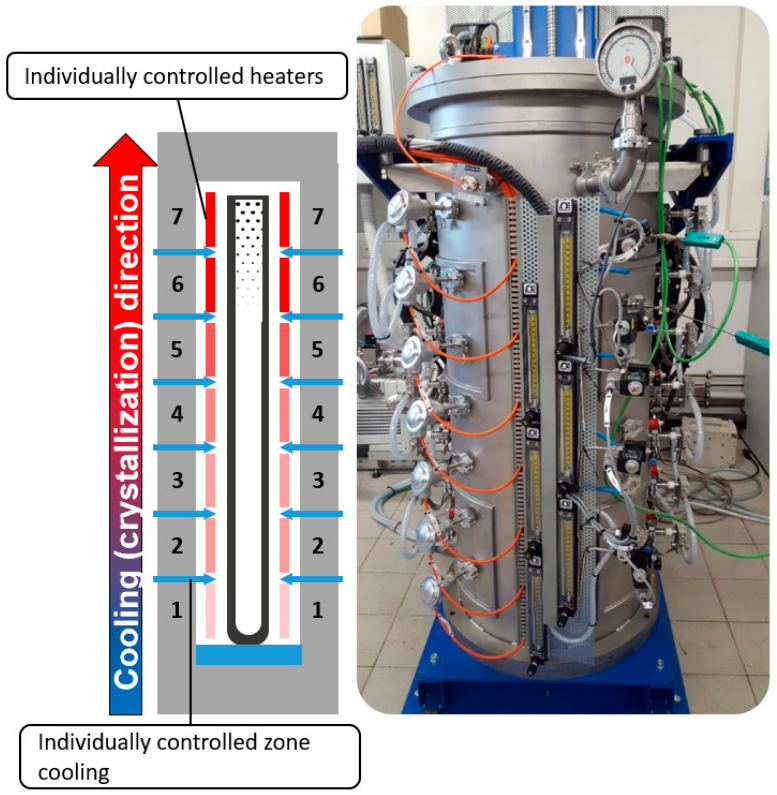
Figure 3. Static crystallization furnace.